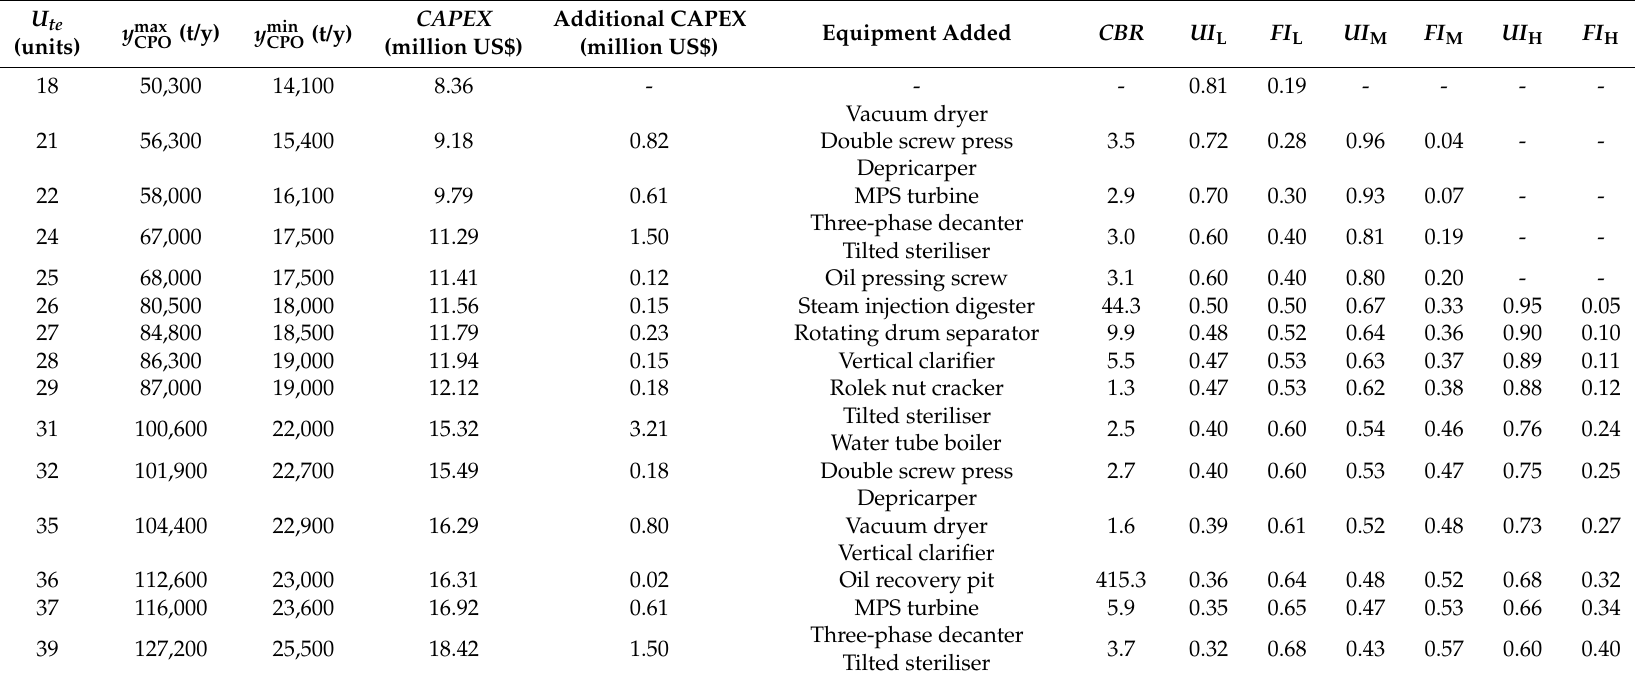
Table 11. Feasible operating range analysis